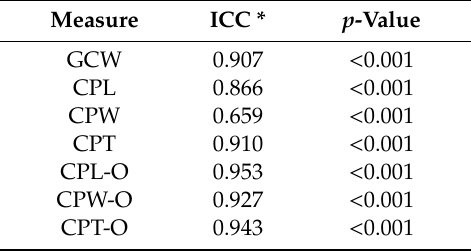
Table 1. Analysis of interobserver reliability.